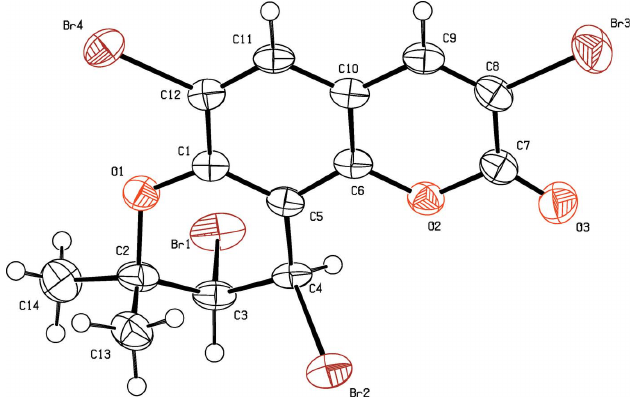
Figure 2 The molecular structure of the title compound with the atom labelling and displacement ellipsoids drawn at the 50% probability level